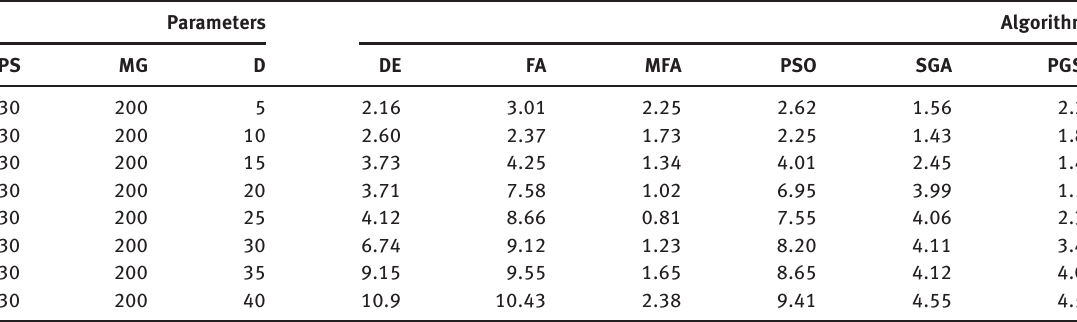
Table 12. Standard Deviation on Different Dimensions.